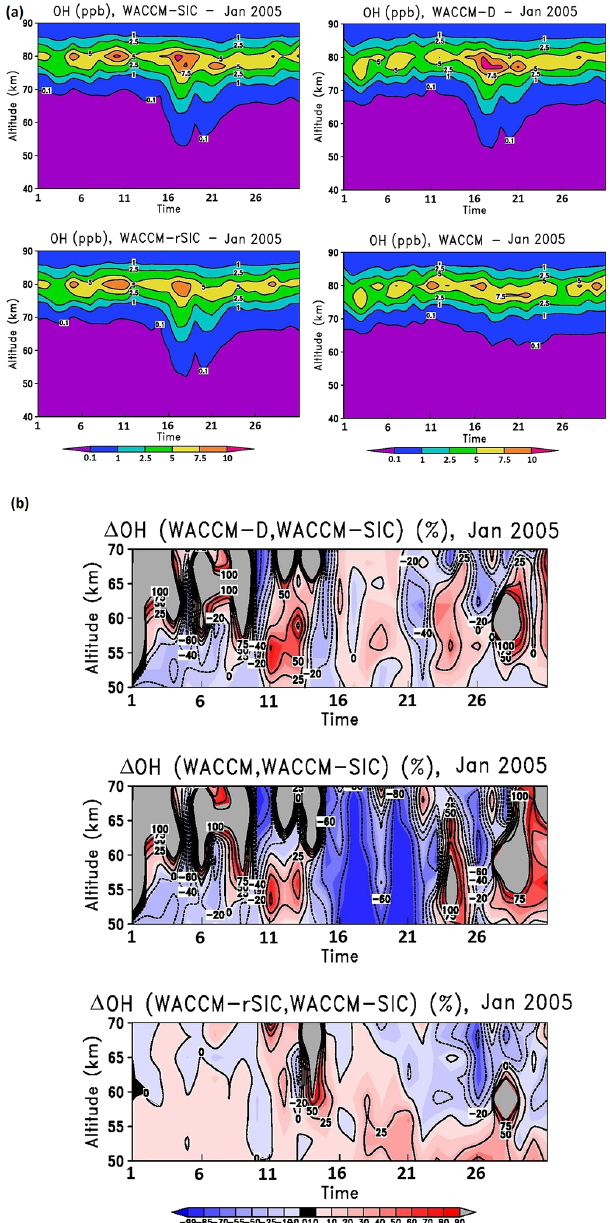
Figure 6. (a) Zonal mean vertical concentration profiles of mesospheric/upper-stratospheric OH (in ppb) for Northern Hemi- sphere polar latitudes (60–90 ◦ N) during January 2005; (b) percent- age difference between three models (WACCM-D, WACCM and WACCM-rSIC) and the full